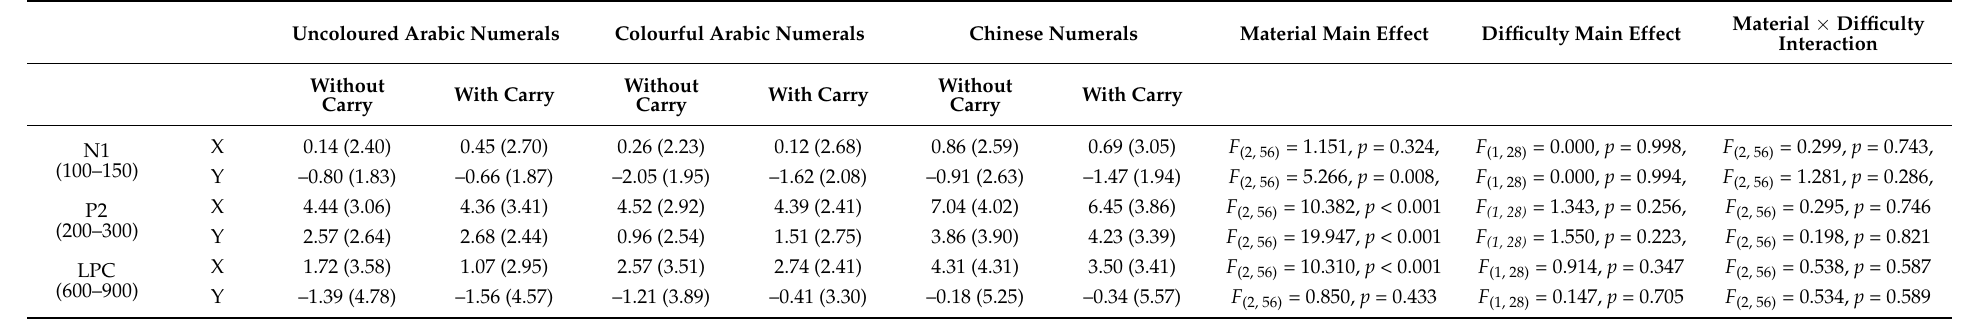
Table 2. The mean amplitudes ( µ V) of the N1, P2, and LPC components for the augend number (X) and the addend number (Y) stimulus are provided for the three separate material categories (uncoloured Arabic numerals, colourful Arabic numerals, and Chinese numerals) at two different difficulty levels (addition without carryover and addition with carryover). Standard deviations are shown in